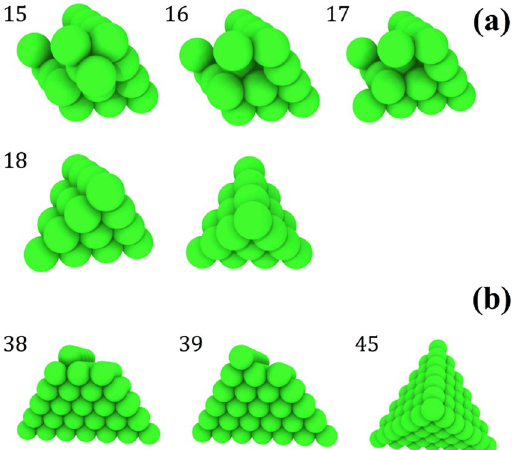
Figure 7. SFT formation. Illustration of the growth of a perfect stacking fault tetrahedron as a function of recoil number, where spheres represent empty lattice sites (vacancies). ( a ) A perfect stacking fault tetrahedron formation in Ni 80 Fe 20 , gradually formed at 15, 16, 17 and 18 consecutive recoils. The final view shows a different angle of the SFT after the 18 th recoil. ( b ) Gradual SFT formation in Ni at 38, 39 and 45